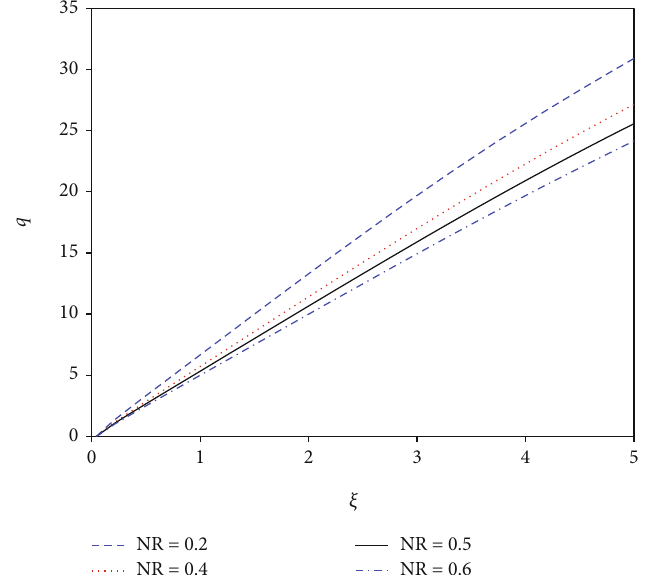
, when n = 0 : 5, ξ = 5, Pr = 10, S = 1, Ω = 0 : 1, andHe = 0 : 2 : R